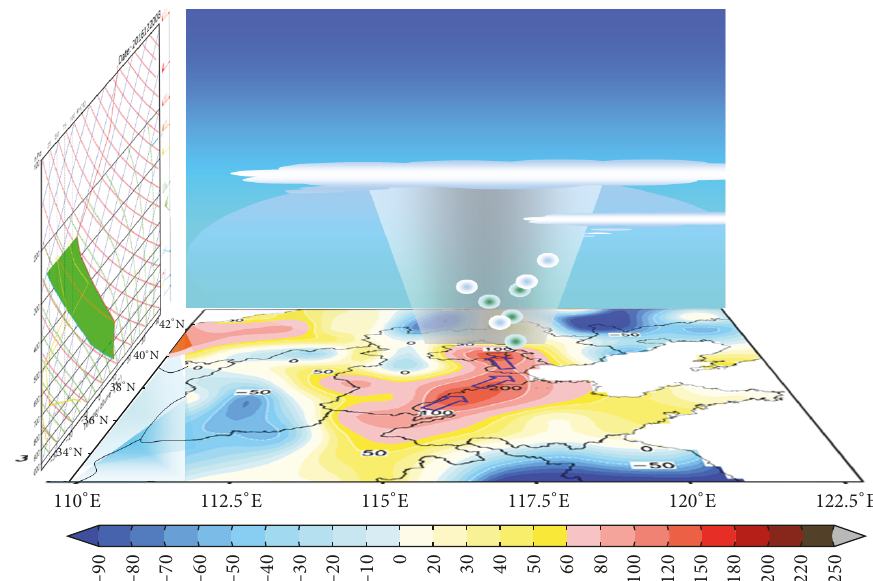
Figure 6: A physic schema shows the mechanism for forming the severe hazy weather or heavy pollution event in December 2016 in Beijing. Left section (tephigram): CIN exceeding the threshold value (shown in the green area) indicated that lowered H PML ↓ is favorable for accumulationofPM 2.5 ↑ .Isentropic (𝜃𝑒)